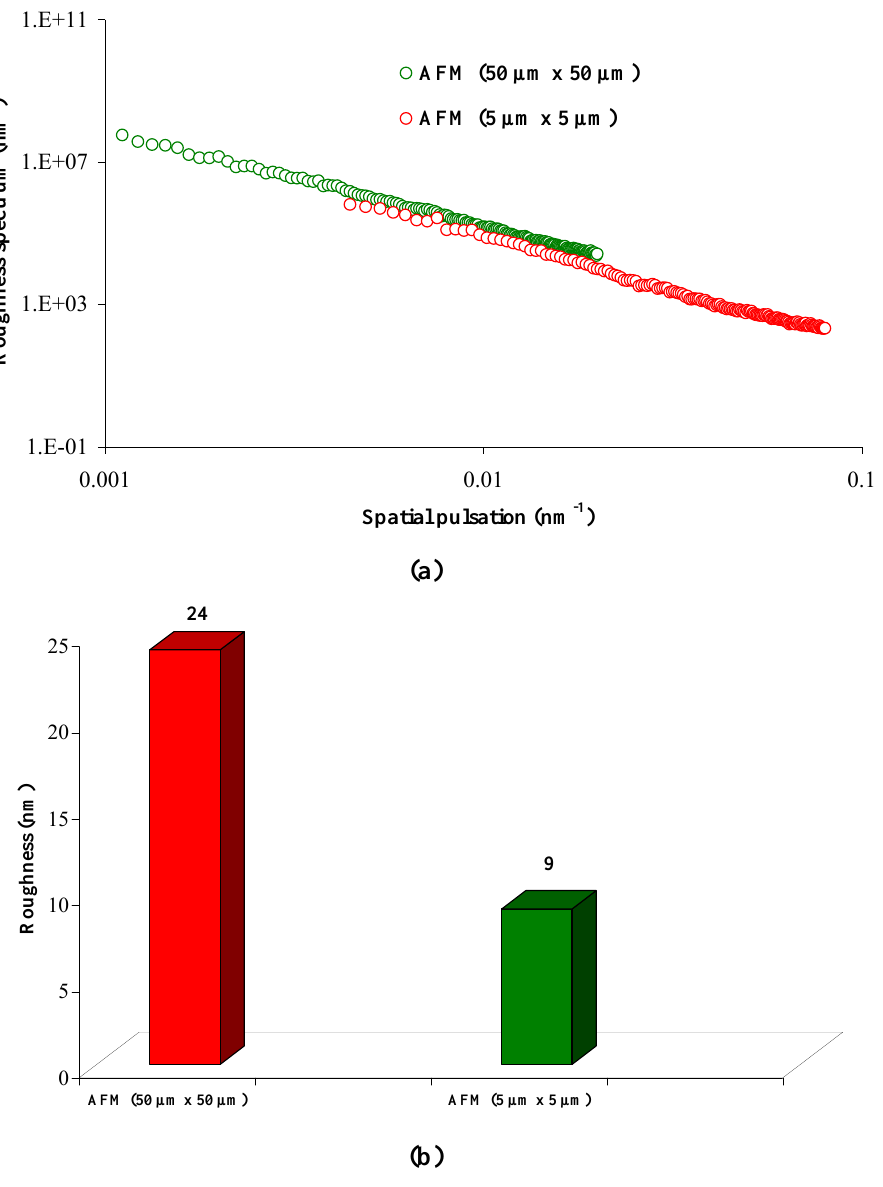
Figure 2. Roughness spectrum (a) and evolution of the roughness (b) for the hollow fiber (100 kDa, PVDF) by AFM for 50 µm × 50 µm and 5 µm × 5 µm